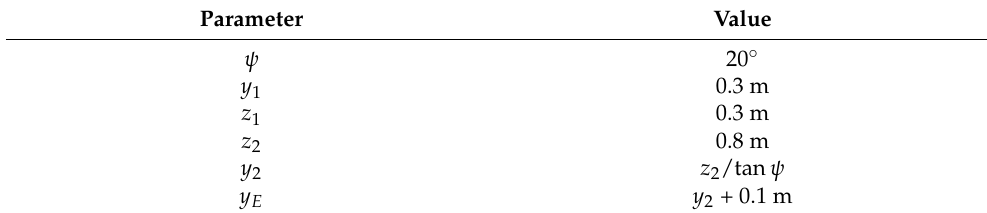
Table 2. Suspension parameters.